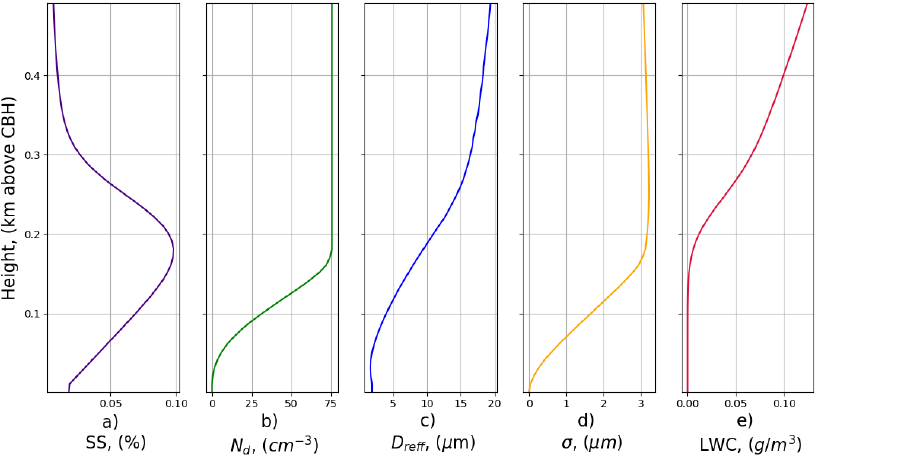
Figure A3. Early development of cloud properties: ( a ) supersaturation (SS), ( b ) droplet number concentration ( N d ), ( c ) droplet effective radius ( D ref f ), ( d ) standard deviation ( σ ), ( e ) liquid water content (LWC) in air ascending at constant velocity of 2